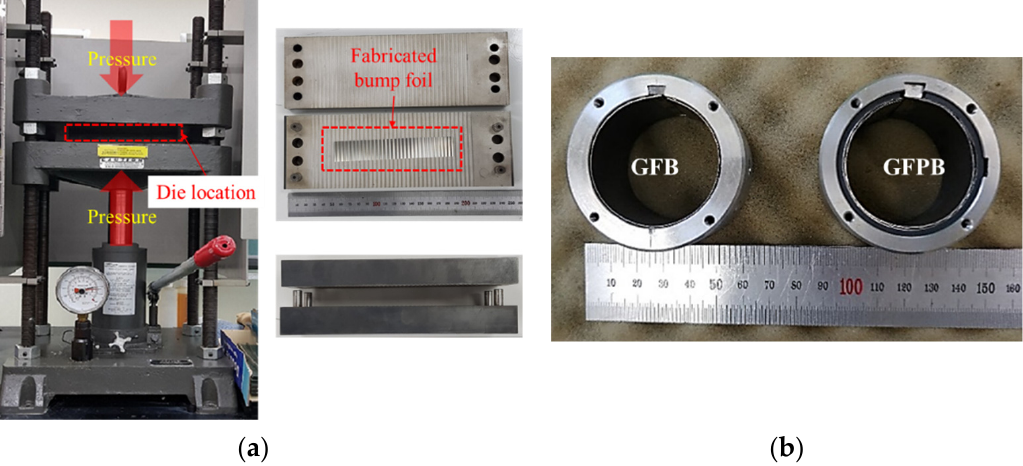
Figure 2. Photos of bearing fabrication process: ( a ) a hydraulic press for bump foil forming, and ( b ) fabricated test GFB and GFPB. Table 1. Test bearing design parameters.